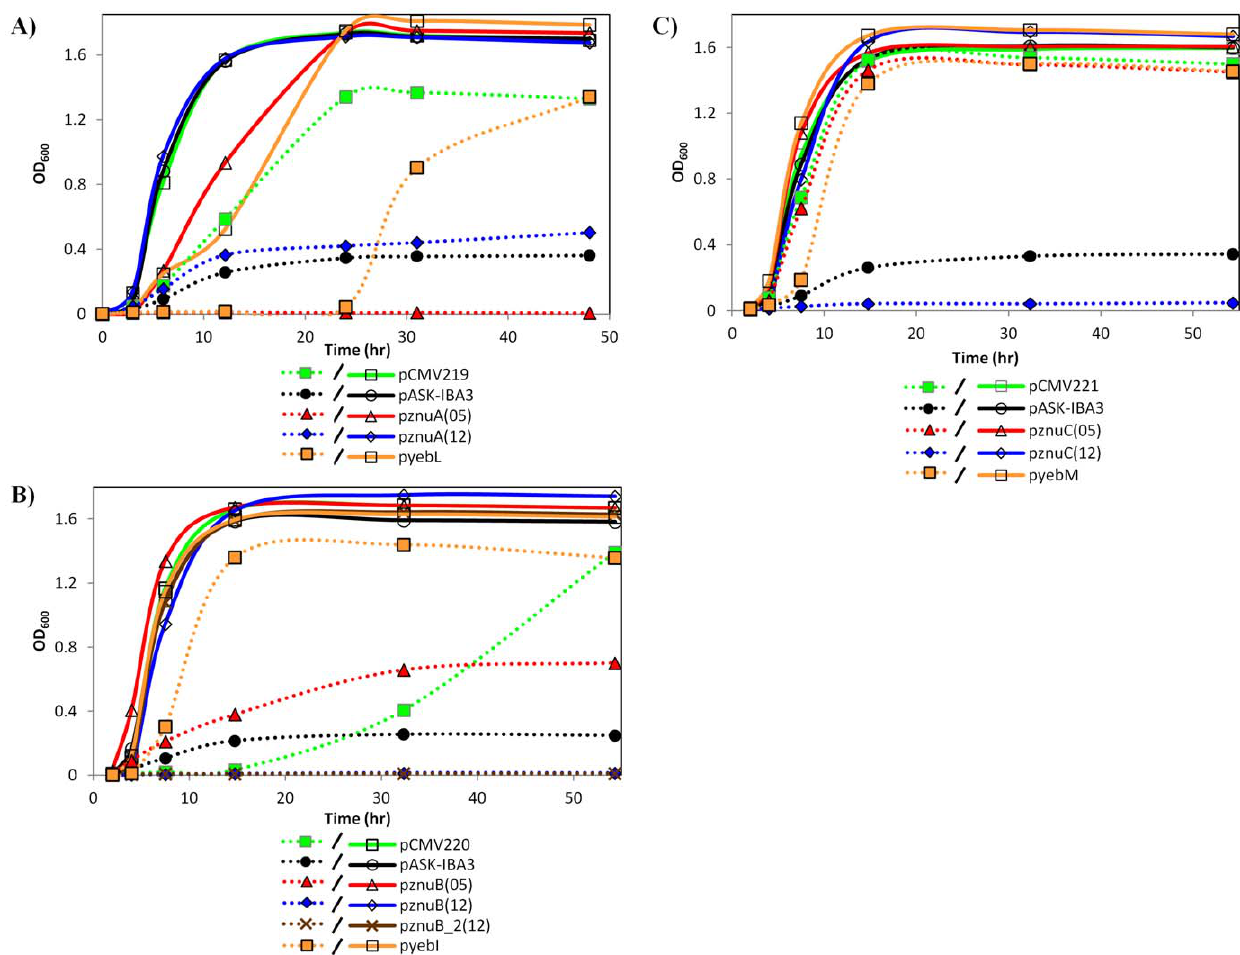
Figure 3. Growth of E. coli complemented strains. Strains of E. coli with A) znuA, B) znuB, or C) znuC insertionally inactivated were complemented with the corresponding znu genes from either S. meliloti (green), E. coli (orange), or Ca. Liberibacter asiaticus (red, blue, and brown) or the vector control (black). Strains were grown both in the absence (solid lines) and presence (dotted lines) of 0.4 mM EDTA. The absorbance at 600 nm (OD 600 ) was measured at the time points indicated. Graphs are representative of data from three independent experiments. doi:10.1371/journal.pone.0037340.g003 neither the znuB (Fig. 3B, dotted blue and brown lines) nor strains containing znuA from gene cluster # 1 of Ca. Liberibacter the znuC genes from gene cluster # 2 of Ca. Liberibacter asiaticus asiaticus (Fig. 3A, solid red line) and E. coli (Fig. 3A, solid (Fig. 3C, dotted blue line) were able to complement the system orange line) . Even though the final OD 600 value was not as high when strains were grown in TY + 0.4 mM EDTA, strains containing znuA , znuB , and znuC from S. meliloti (Fig. 3A–C, these strains were below those of the vector control. dotted green lines) appeared to complement the growth defect seen when only the vector control was present (Fig. 3A–C, dotted black lines) . These strains reached an OD 600 that was similar to the E. coli controls (Fig. 3A–C, dotted orange lines) . Furthermore, the strain containing znuC from gene cluster # 1 of Ca. Liberibacter asiaticus (Fig. 3C, dotted red line) was also able to grow to an equivalent density. Interestingly, the OD 600 of the strain expressing znuB from gene cluster # 1 of Ca. Liberibacter asiaticus (Fig. 3B, dotted red line) was less than cultures containing the E. coli or S. meliloti alleles but more than 2.5-fold greater than the vector control strain. This strain also showed dense growth on TY plates containing 0.4 mM EDTA compared complement the D znuB phenotype. Neither of the two znuA genes from Ca. Liberibacter asiaticus (Fig. 3A, dotted red and blue lines) appeared to complement the D znuA strain. In addition,